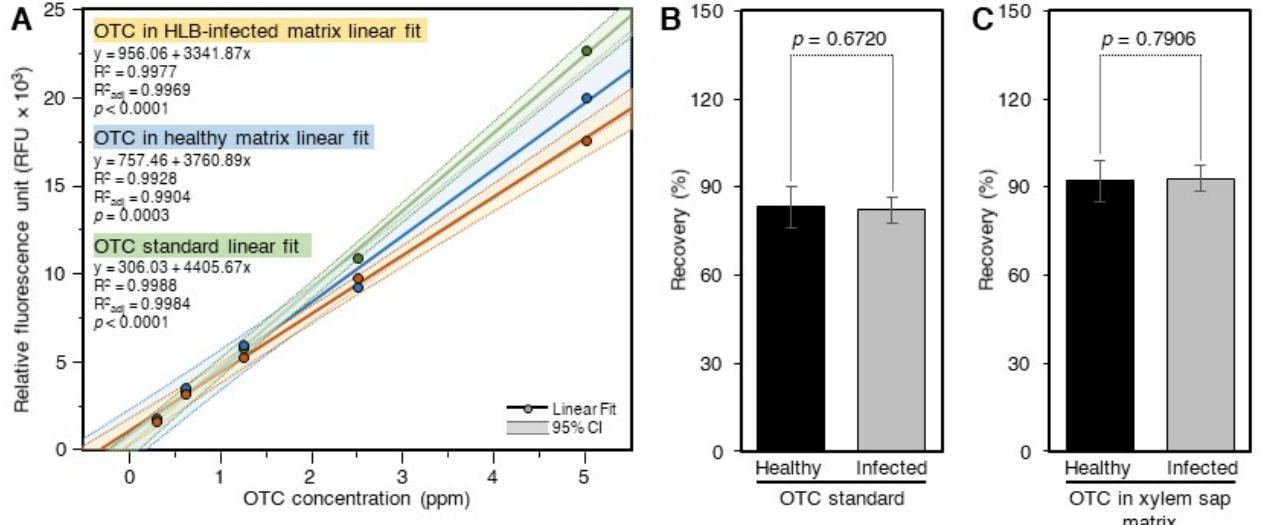
Figure 4. Recovery of OTC from spiked citrus xylem sap. ( A ) Standard curves of OTC in 60% methanol and citrus xylem sap obtained from healthy and ‘ Ca. L. asiaticus’-infected plants. The standard curves in the phloem sap matrix were prepared by spiking xylem sap extracts with OTC and then purifying them using SPE. ( B ) Recovery of OTC from spiked ‘ Ca. L. asiaticus’-infected and healthy xylem sap as calculated using the pure OTC standard curve. ( C ) Recovery of OTC from spiked ‘ Ca. L. asiaticus’-infected and healthy xylem sap as calculated using the OTC standards prepared in the xylem sap extracts and cleaned using SPE. Data are the means ± SD of five replicates ( n = 5). Values with p -values < 0.05 are significantly different using a two-tailed student t -test.